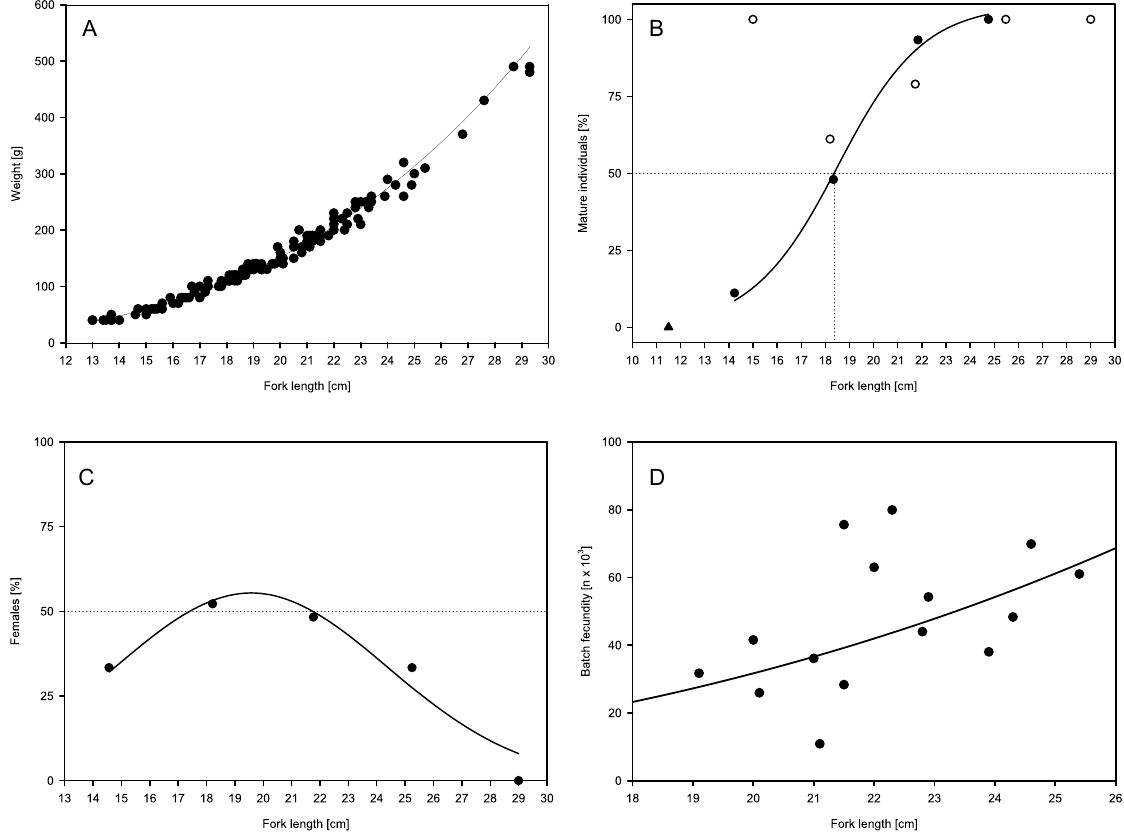
Fig. 3. Parupeneus indicus from the Kamiali Wildlife Management Area, Papua New Guinea: Length–weight relation ( A ); L for females (closed circles, solid line), males and undifferentiated individuals are represented by open circles 50 and triangles, respectively ( B ); Size-specifi c sex ratios for mature individuals ( C ); Length–fecundity relation (